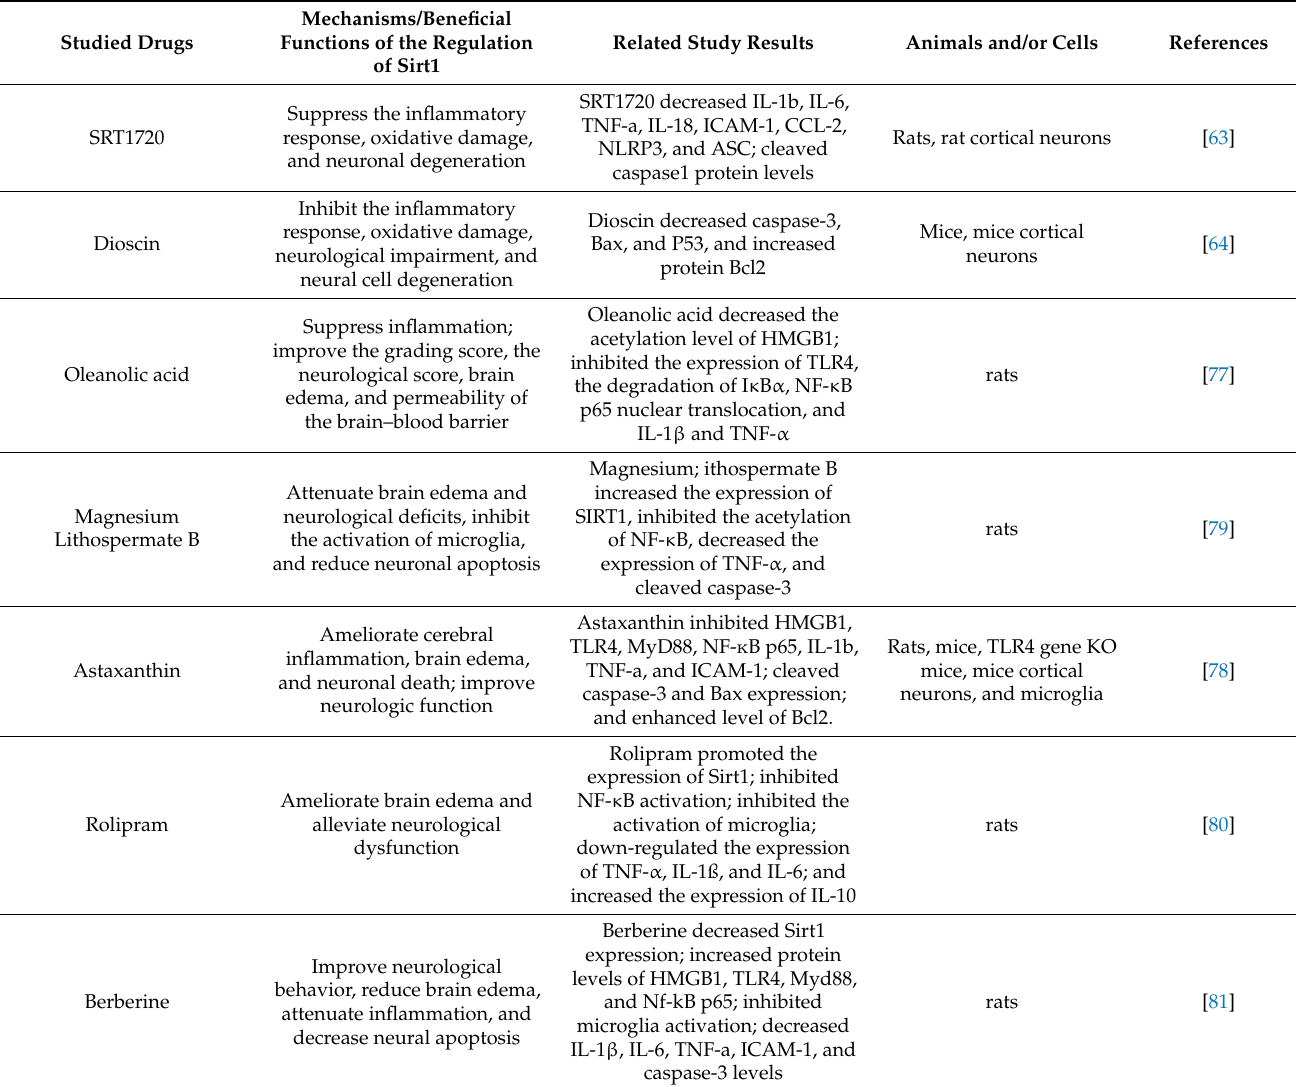
Table 1. Related studies exploring Sirt1-targeted anti-inflammation therapy for